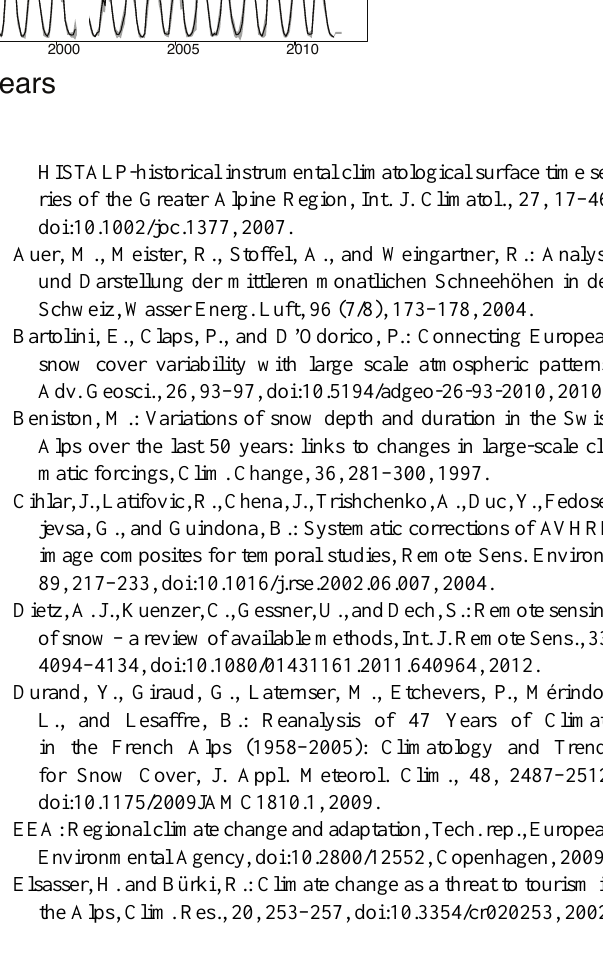
Fig. A.1. Time series (1985–2011) of absolute monthly values of SCA for each region including monthly standard deviation (gray shaded